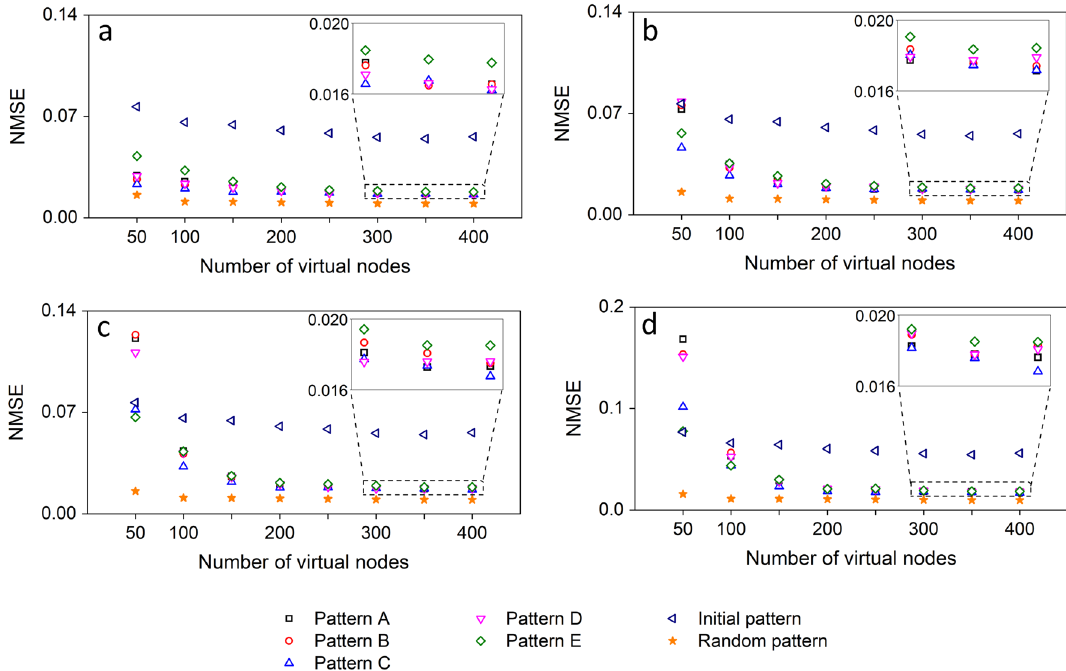
Figure 7. NMSE performance of the Santa-Fe timeseries one-step-ahead prediction benchmark task with TDRC, when using the sampled different patterns (A–E) that originate from the SL-OF system as masking sequences. The performance is evaluated versus the reservoir size V n and under different amplification noise 0 dB, ( b ) NF 3 dB. The NMSE performance is 1 dB, ( c ) NF 2 dB and ( d ) NF conditions: ( a ) NF = = = = compared to the one that uses as masking sequence the sampled initial pattern generated from the SL-OF system (left violet triangles). It is also compared to the one that uses as mask an algorithmic random sequence (orange